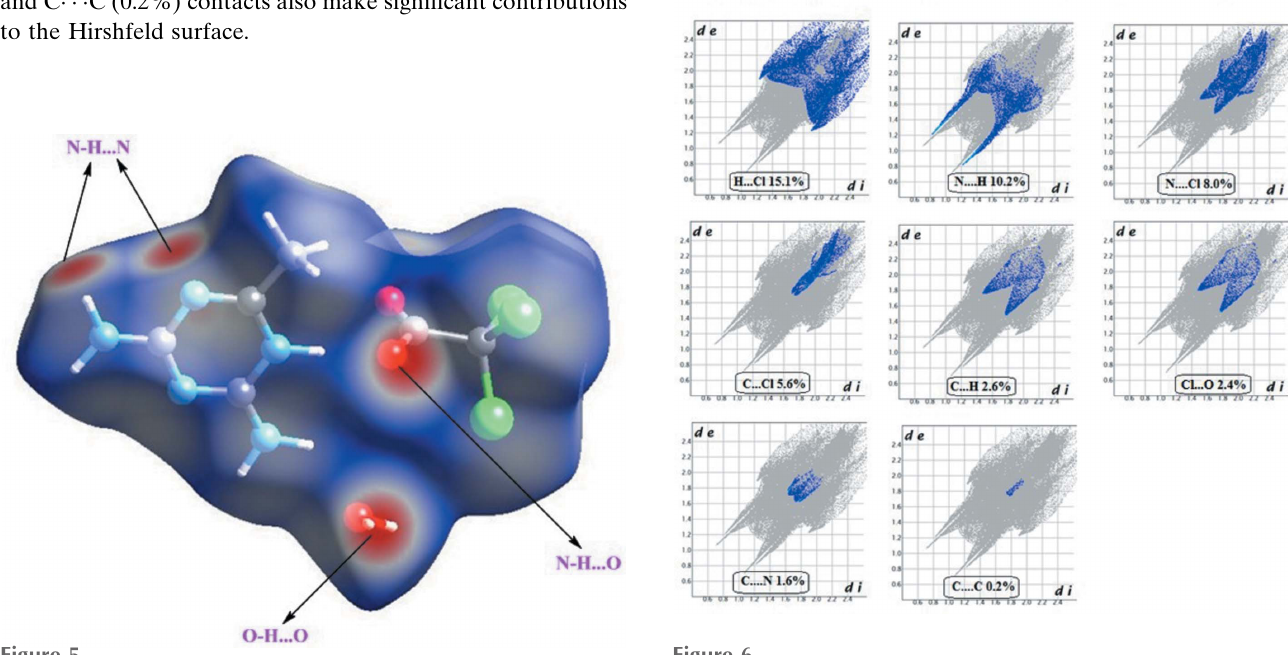
Figure 6 Two-dimensional fingerprint plots for the title compound